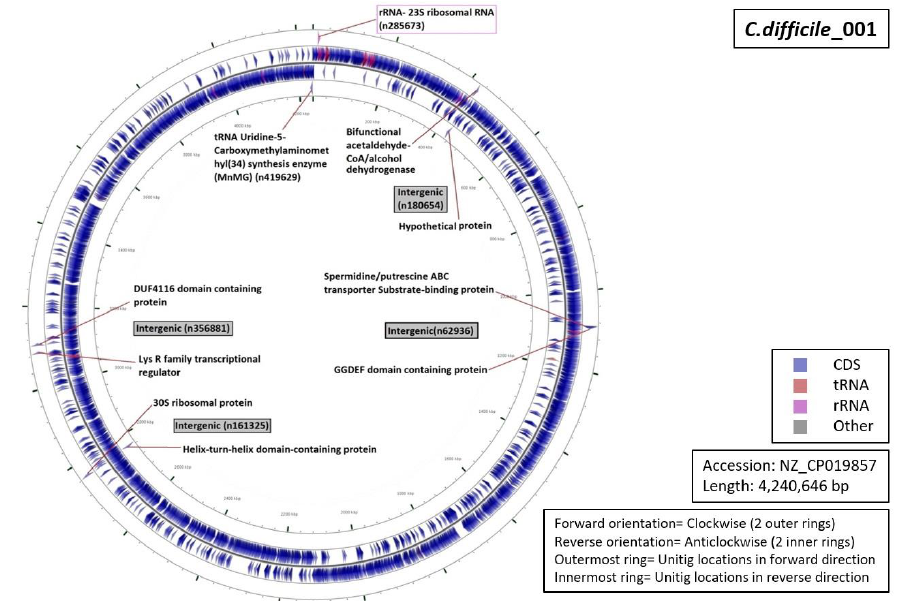
Figure 5. Functional annotation and location of DBGWAS markers on the reference genome of C. difficile RT001. Both central rings represent the genome annotation (reverse inside, forward outside), while the outer and inner rings represent the signature sequences (unitigs) (reverse inside, forward outside).